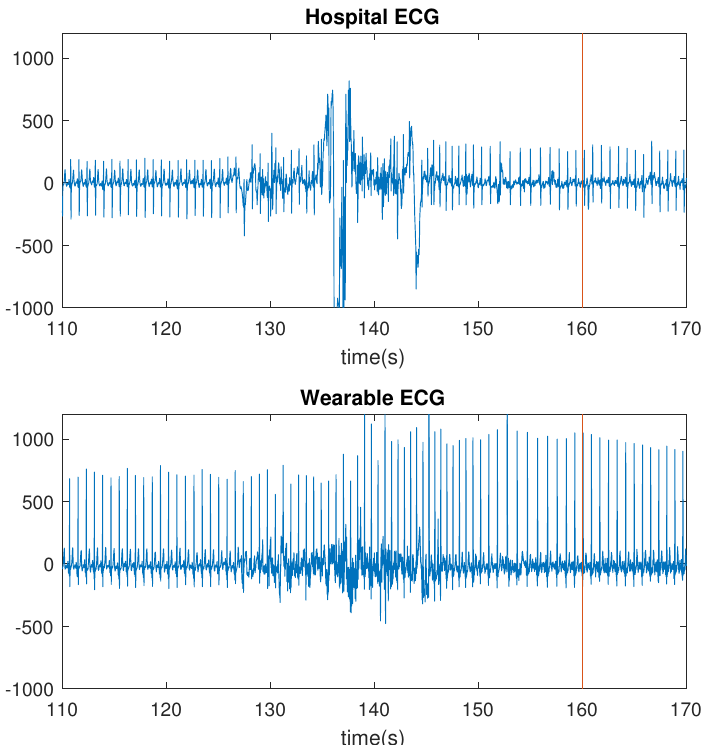
Figure 5. Comparison of motion artifacts: hospital electrocardiography (ECG) and wearable ECG (red line indicates annotated seizure